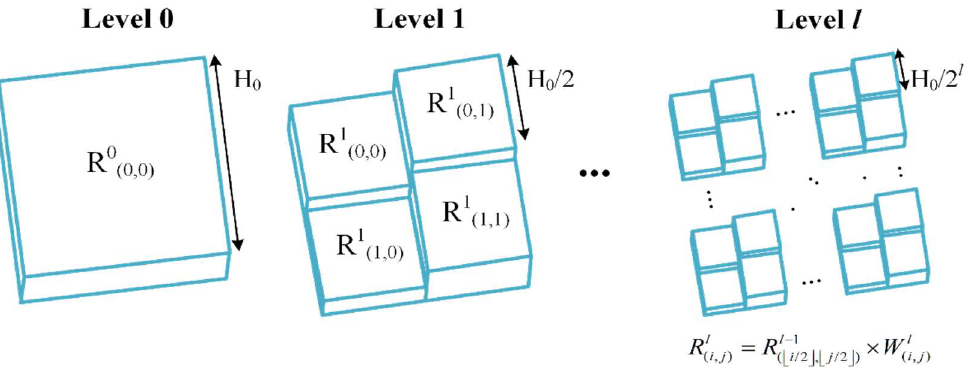
Figure 1. Random cascade processes. Equation (20) for R ((cid:2919),(cid:2920))(cid:2922) , the l-th level estimated precipitation in cell (i,j).